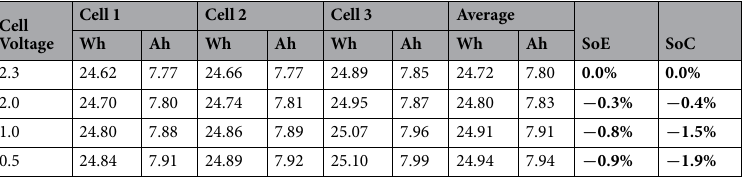
Table 3. Showing the energy extracted in Wh and Ah by discharging to each voltage in comparison to discharging to the manufacturer recommended 2.3 V. The difference is calculated using the average of three cells.